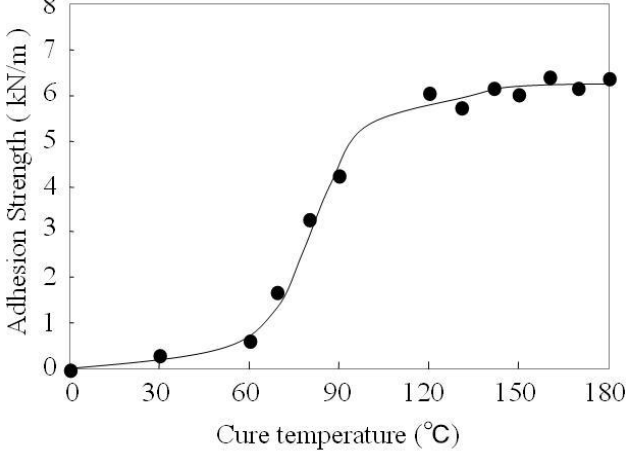
Figure 6. Effect of curing temperature for TES self-assembly monolayer on adhesion strength between aluminum substrate and EPDM rubber. (TES concentration: 2.5mmol/L).